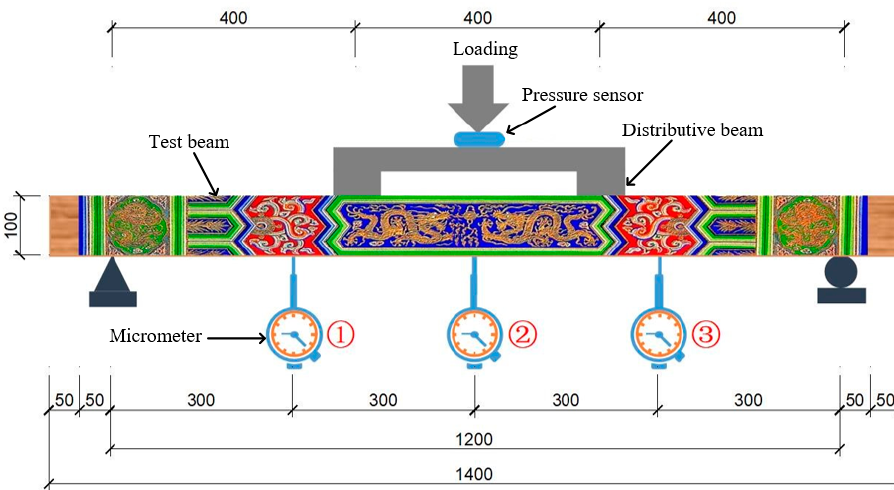
Figure 10. The schematic diagram of the experiment (units: mm).